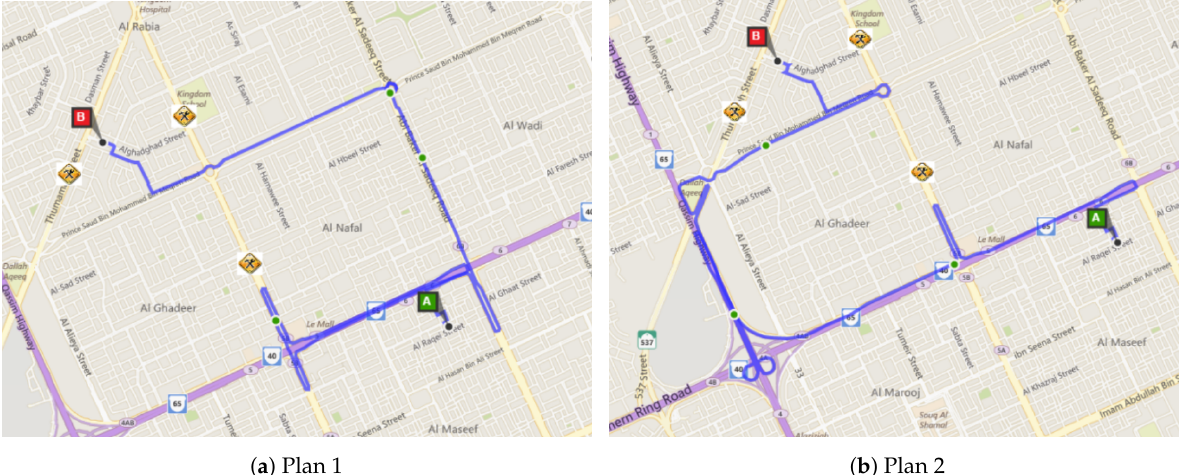
Figure 9. Plan 1 or Plan 2 is an alternative route from A to B